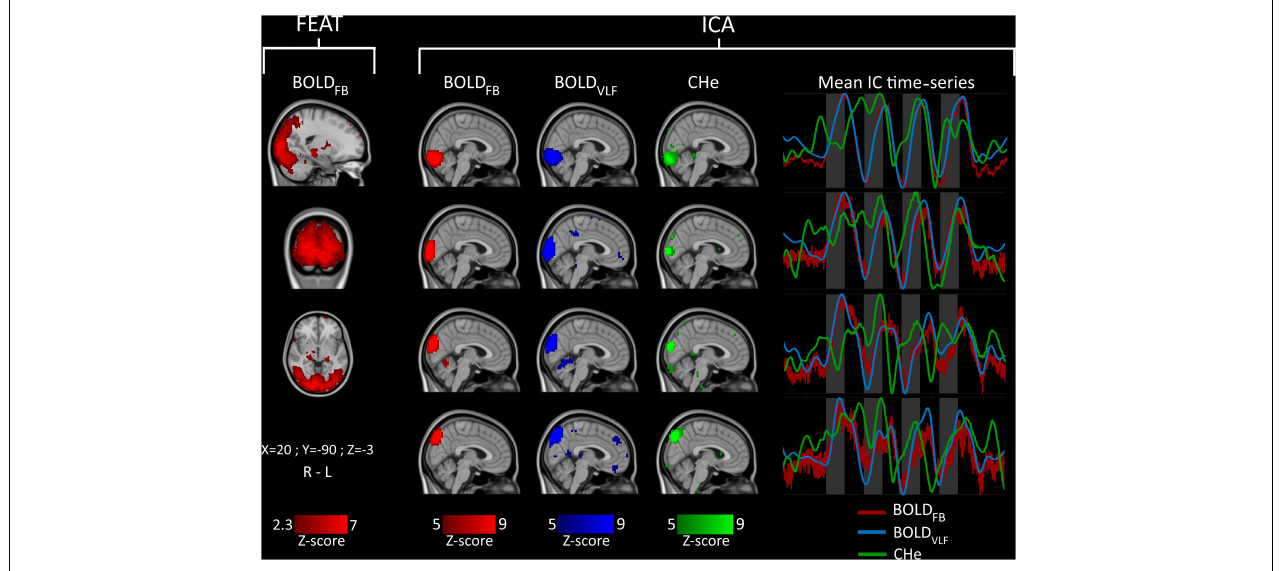
FIGURE 2 | Group-level ( n = 23) FEAT (left) and independent component (IC) signal source analysis (right). Mean IC time-series of component regions are shown on the right side of the figure in matching colors. Visual stimuli are marked with gray